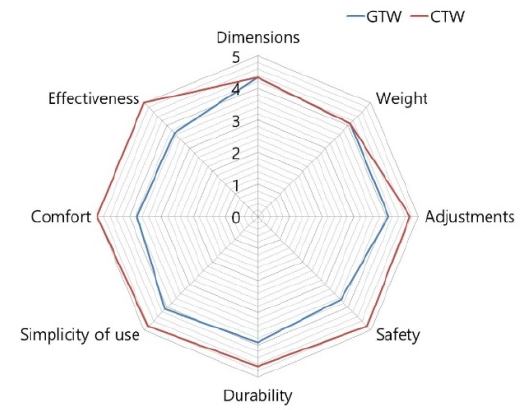
Figure 10. Satisfaction distribution.